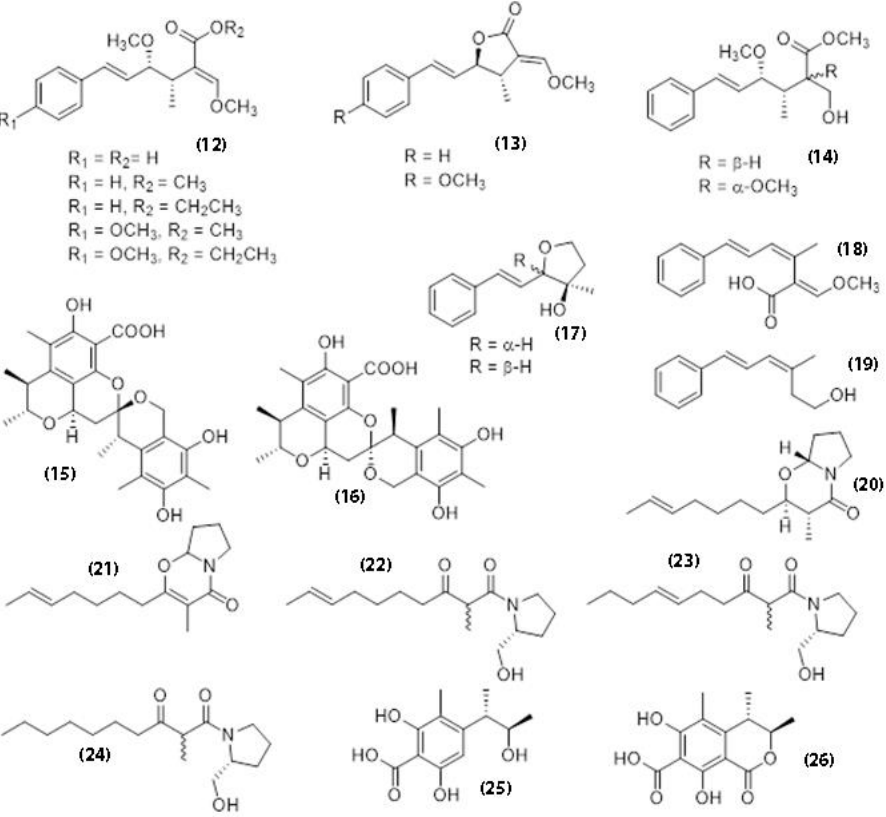
Figure 7. Chemical structures of compounds identified from Xerula sp. BCC56836 with antifungal and insecticidal properties.